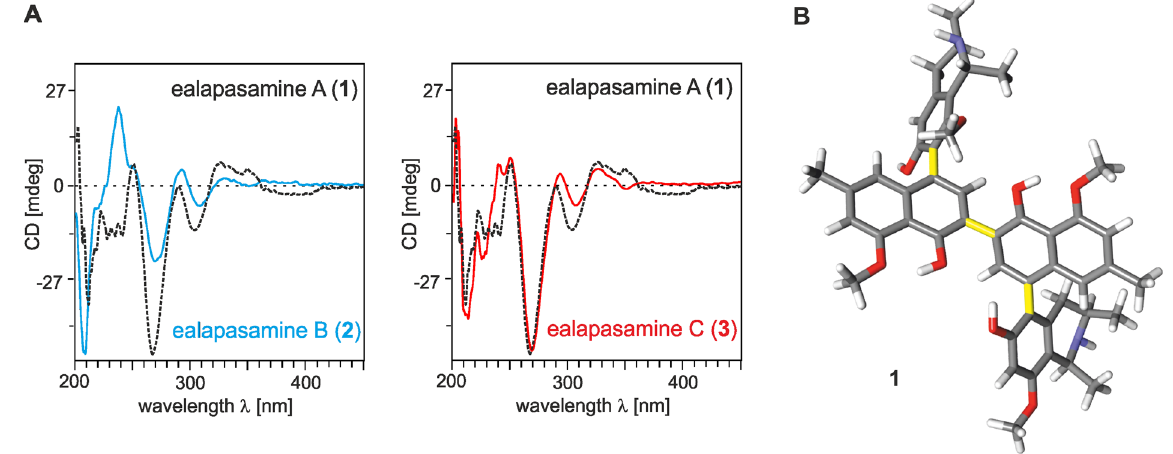
Figure 6. ( A ) ECD spectra of ealapasamines (A–C) ( 1 – 3 ) recorded in MeOH. ( B ) One DFT-optimized conformer of 1 .